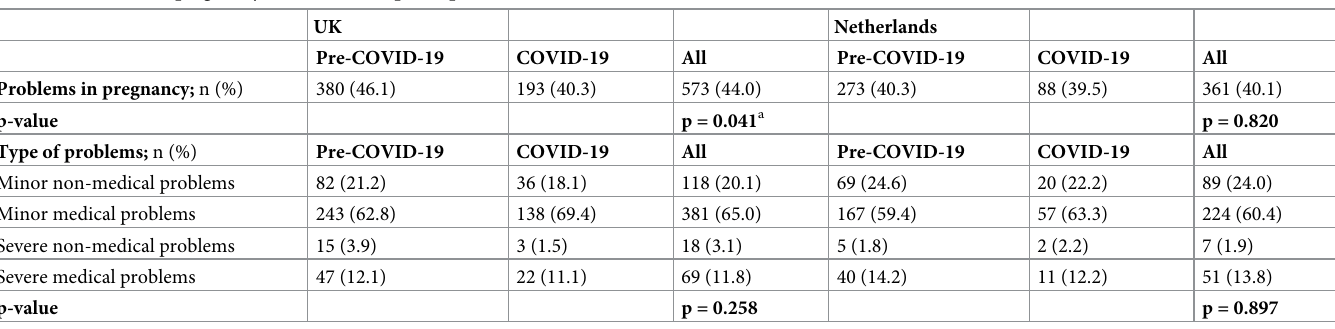
Table 3. Problems in pregnancy of the included participants.